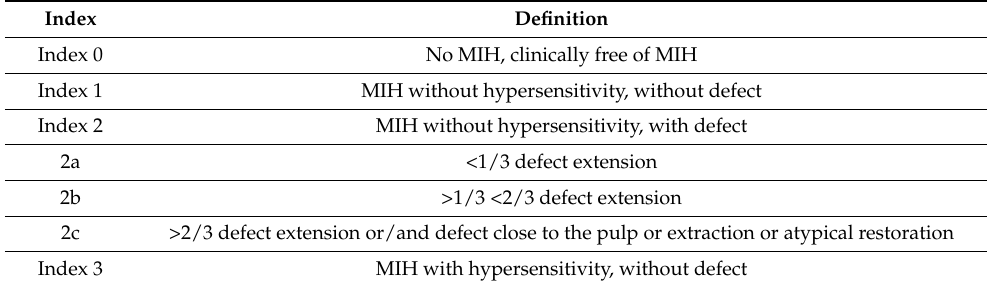
Table 1. The MIH Treatment Need